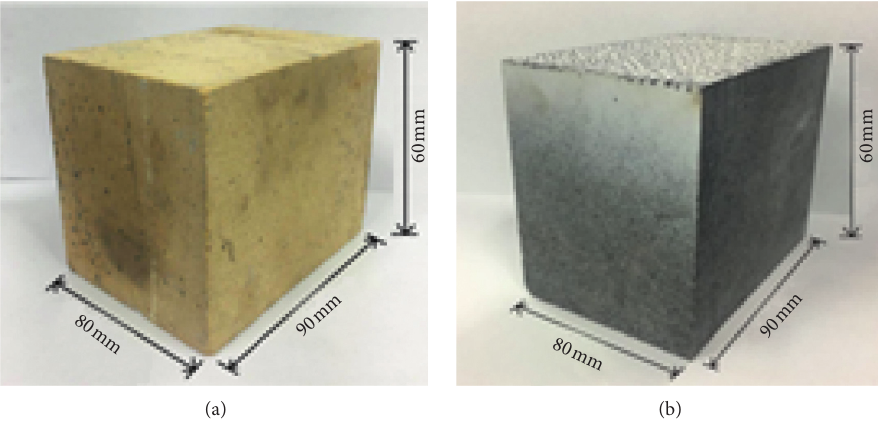
Figure 6: Rock samples. (a) Sandstone sample. (b) Granite